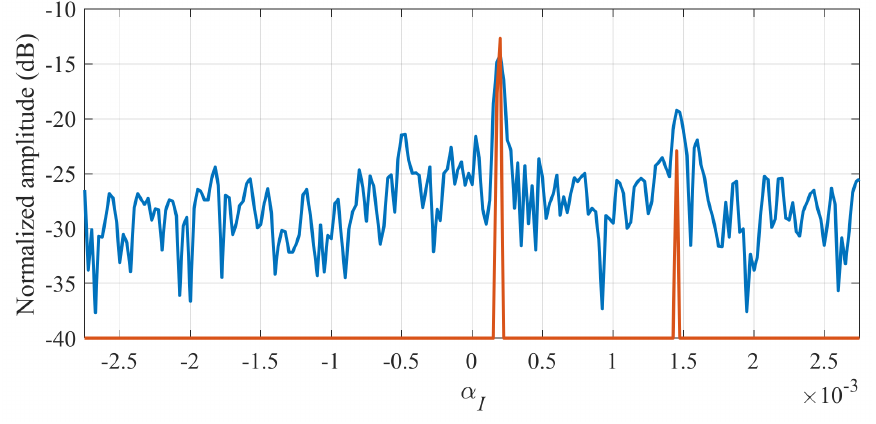
Figure 10. Sidelobe reduction and resolution improvement as observed from the cross-sections of Figure 9a,b for an ordinate with two isolated targets.